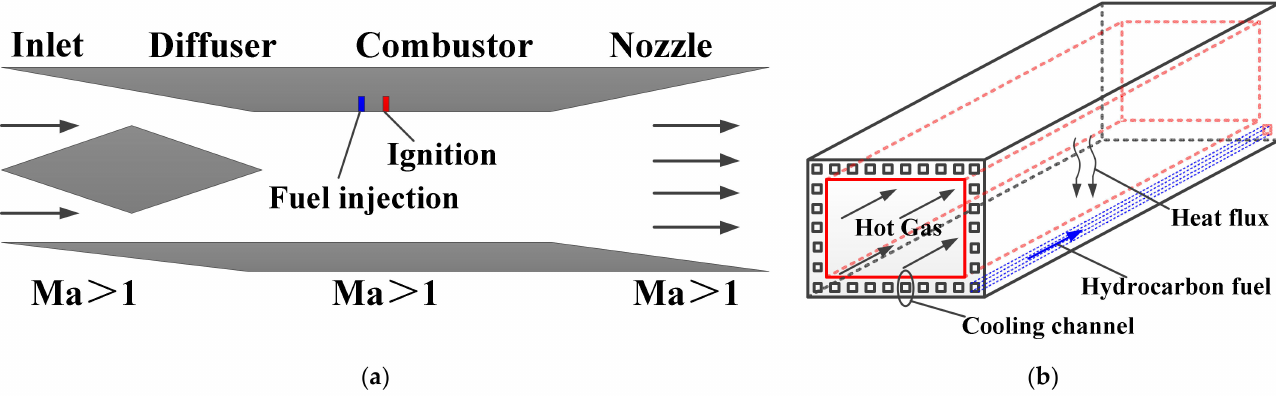
Figure 2. Schematic diagram of scramjet engine and regenerative cooling: ( a ) Scramjet engine ( b ) Regenerative cooling. The experimental photos of scramjet engine and regenerative cooling are shown in Figure 3. The temperature and heat flux of the gas heated surface are measured by embed- ded thermocouples and heat flux sensors in the experiments. However, the installation